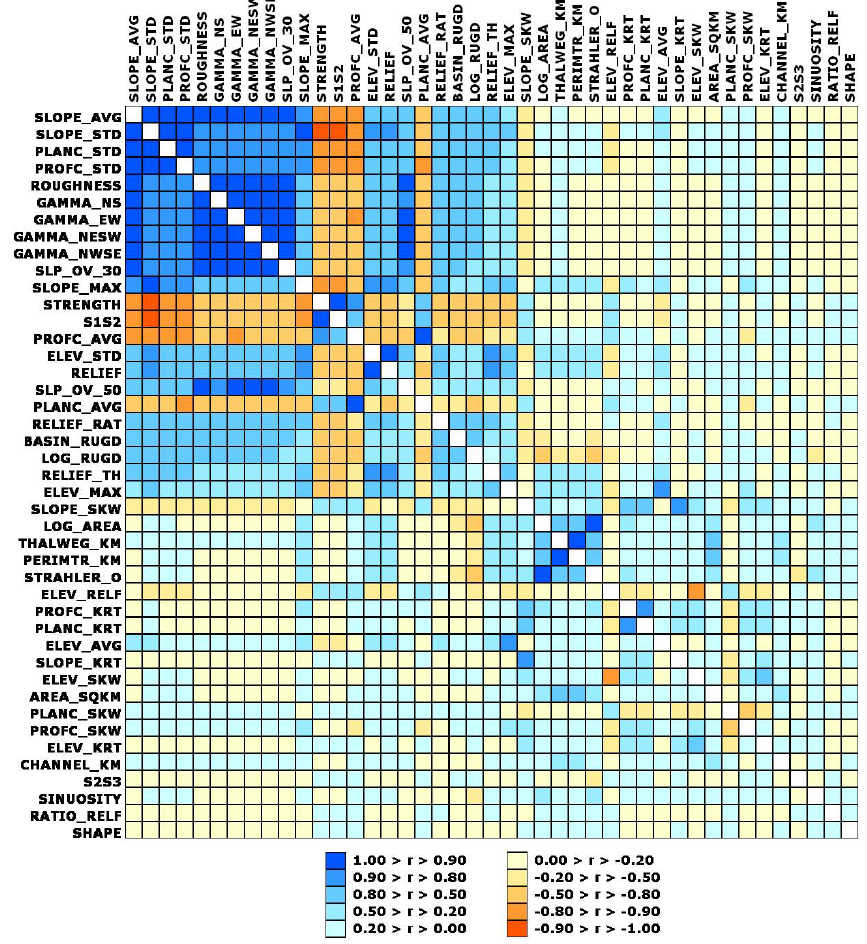
Fig. 8. Correlation matrix for the parameters in Appendix B for all drainage basins larger than 100km 2 , listed in order of parameter